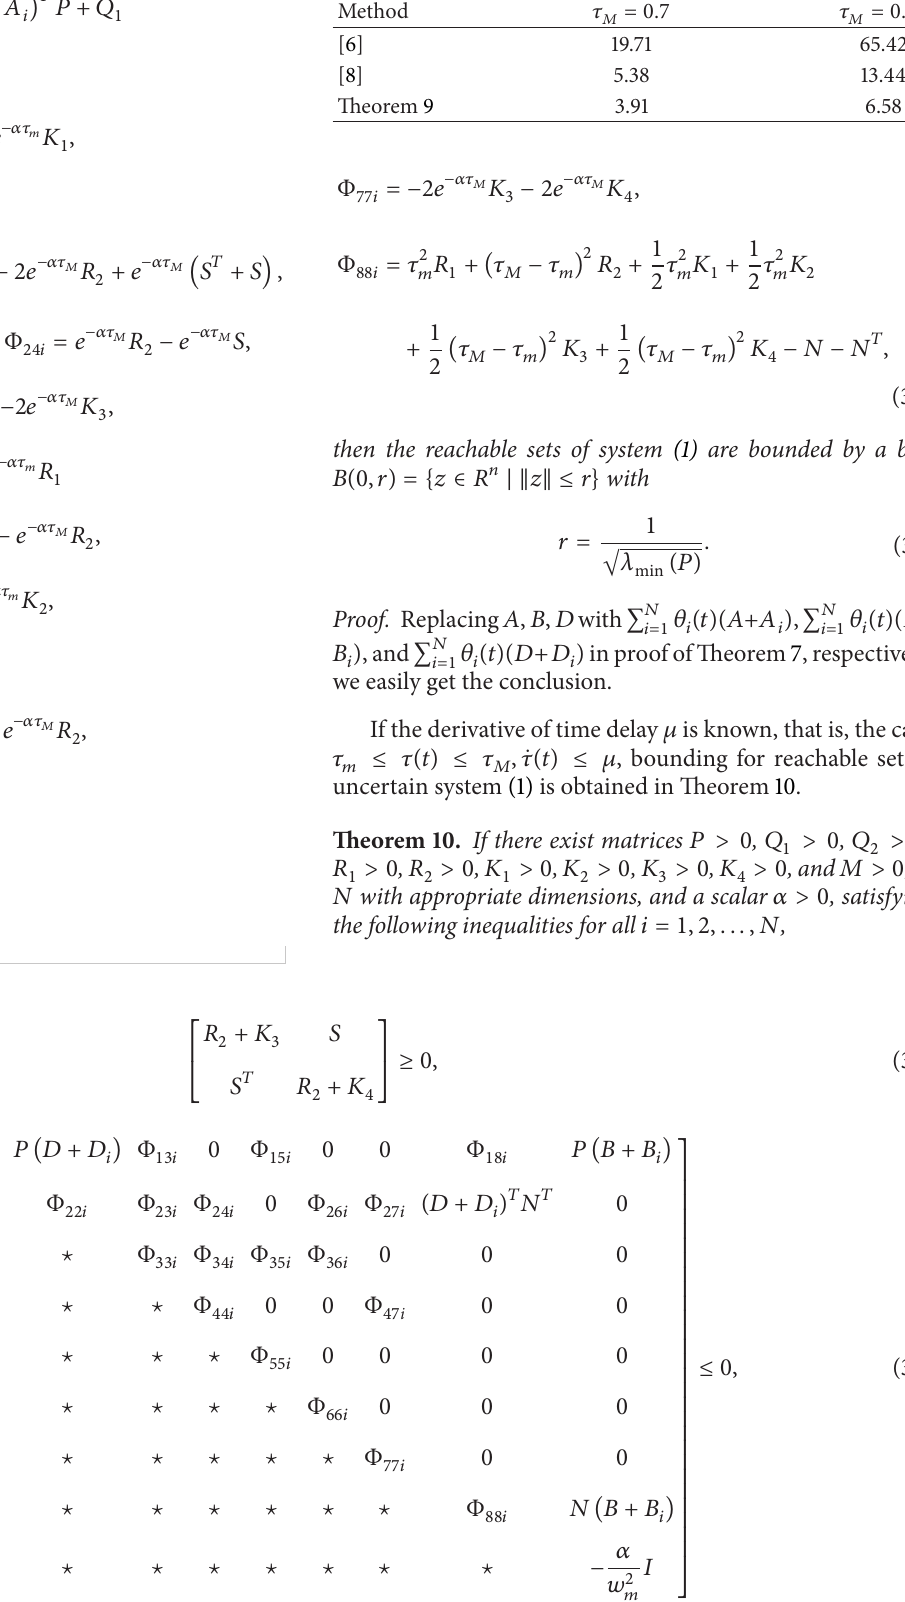
Table 1: Computed 𝛿 ’s of Example 1 for the case 𝜏 𝑚 ≤ 𝜏(𝑡) ≤ 𝜏 𝑀 with = 0 . 𝜏 𝑚 Method 𝜏 𝑀 =